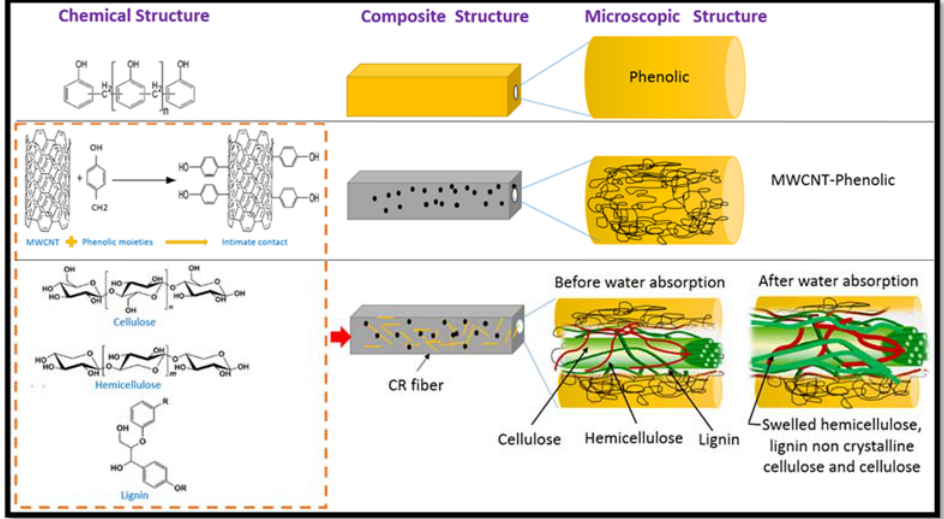
Figure 5. Schematic diagram of water absorption of CR fiber ‐ reinforced MWCNT ‐ Phenolic compo ‐ sites.